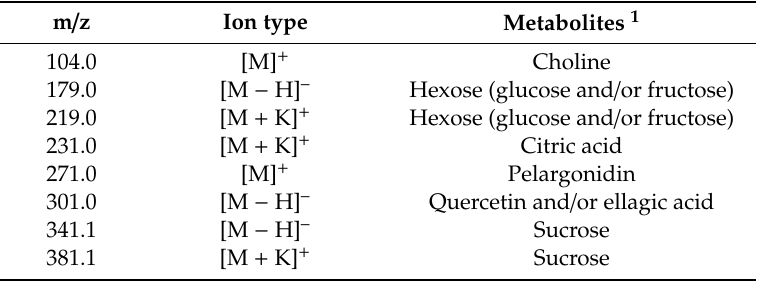
Table 1. Assigned metabolites on strawberry fruit